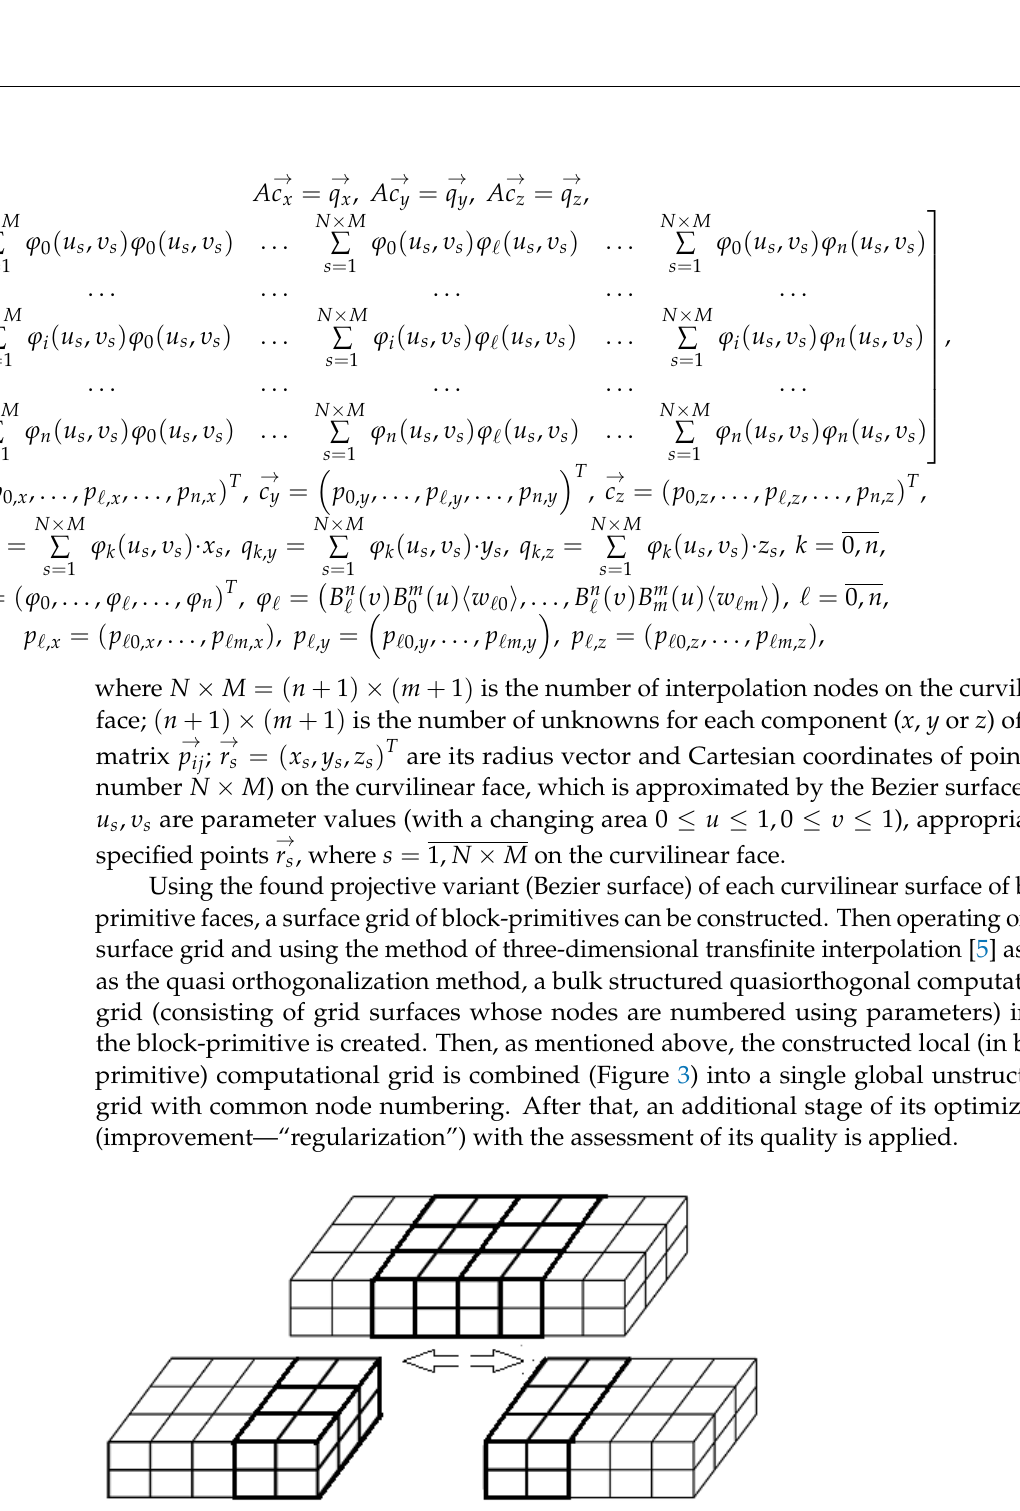
Figure 3. Formation of a single global unstructured grid. For numerical adaptation (to the solution peculiarities) of the volumetric computa- tional grid, the results of [6] or the principle of uniform distribution (equidistributional method) of the “adaptation” (weight) function w are